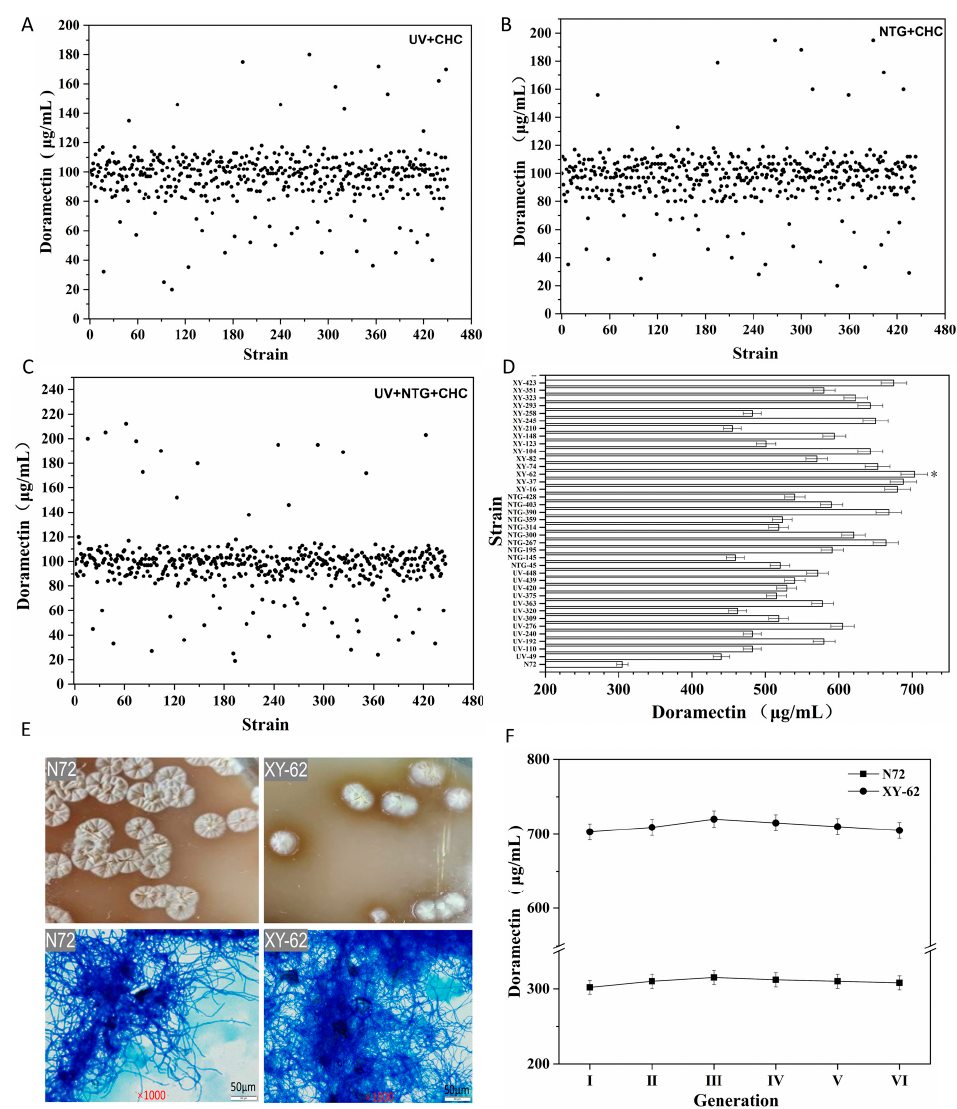
Figure 3. Stability of mutagenic selection and high-yielding strains of S. avermitilis N72. ( A ) single colonies of S. avermitilis N72 after UV mutagenesis and CHC-tolerance screening in a 96-microplate surface culture primary sieve, ( B ) single colonies of S. avermitilis N72 after NTG mutagenesis and CHC-tolerance screening in a 96-microplate surface culture primary sieve, ( C ) single colonies of S. avermitilis N72 after UV and NTG mutagenesis and CHC-tolerance screening in 96-microplate solid- state fermentation primary sieve, ( D ) shake flask rescreening of positive mutant strains (* represents p < 0.05), ( E ) growth pattern of S. avermitilis N72 and high-yielding strain XY-62 in solid medium G and seed medium S, ( F ) enetic stability of S. avermitilis N72 and the high-yielding strain